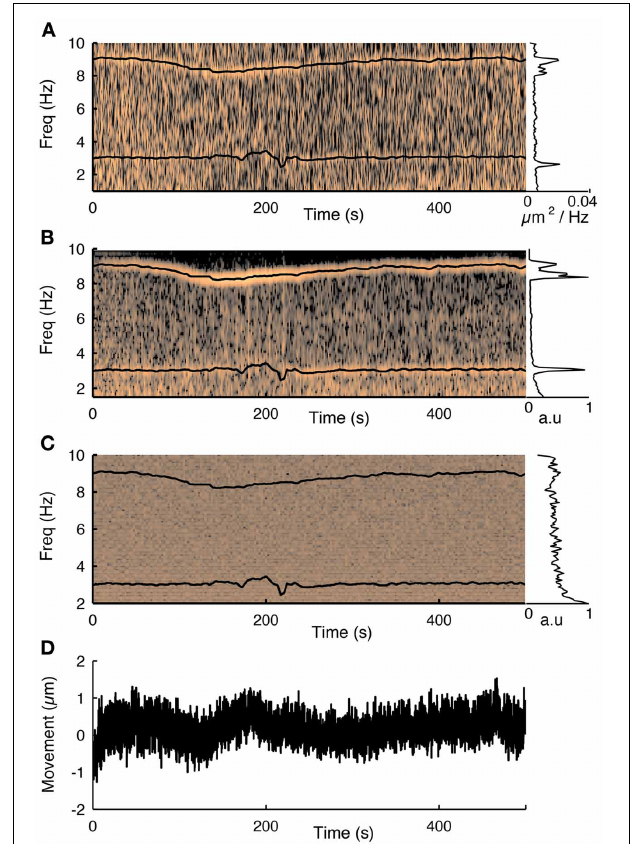
FIGURE 3 | The influence of the cardiac cycle on movement and calcium fluorescence. (A) Spectrogram of the tissue movement computed from motion tracking planes (e.g., Figure 2A , see methods for details) shows a prominent narrow frequency band that changes over time between 7 and 10Hz. The corresponding black trace is the heart rate measured simultaneously with a cardiac monitor. The frequency of the tissue movement matches the heart rate. A second frequency band around 3Hz corresponds to the respiratory cycle, which was also monitored simultaneously and is shown with a black trace. The inset on the right shows the average spectrum over the course of the experiment and shows both these ranges having substantially more power than at other frequencies. (B) The same analysis performed on the first principal component of all fluorescence traces from 76 cells recorded during this session shows that the functional traces are also influenced by the cardiac and respiratory cycles. (C) Spectrogram of the average neuropil from the motion planes. The cardiovascular cycle does not affect the neuropil. (D) Estimated movement for this session. Despite the fact the movement is less than a micron it is sufficient to influence the